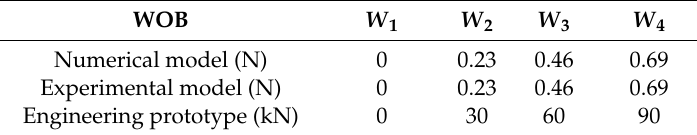
Table 3. The parameter selection of weight on bit (WOB).